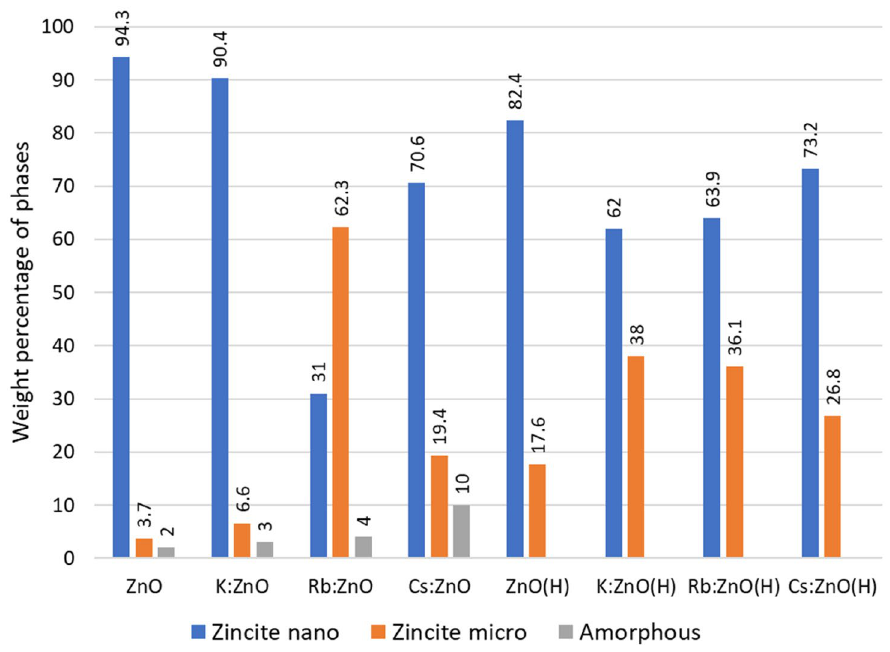
Figure 4. Weight percentage of nano-zincite, micro-zincite and amorphous phases calculated by Reitveld